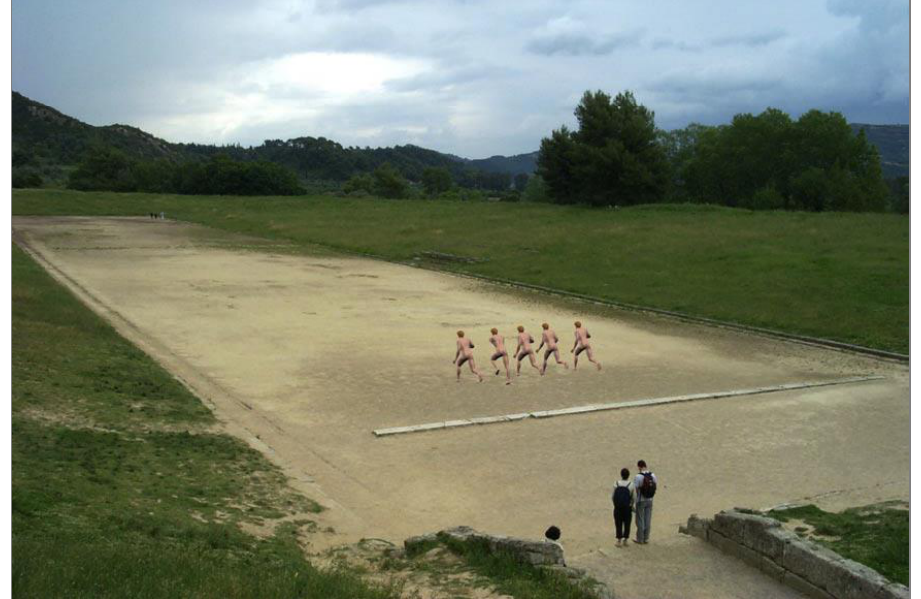
Figure 3 Athletes competing in Olympia (Karigiannis & Stricker,